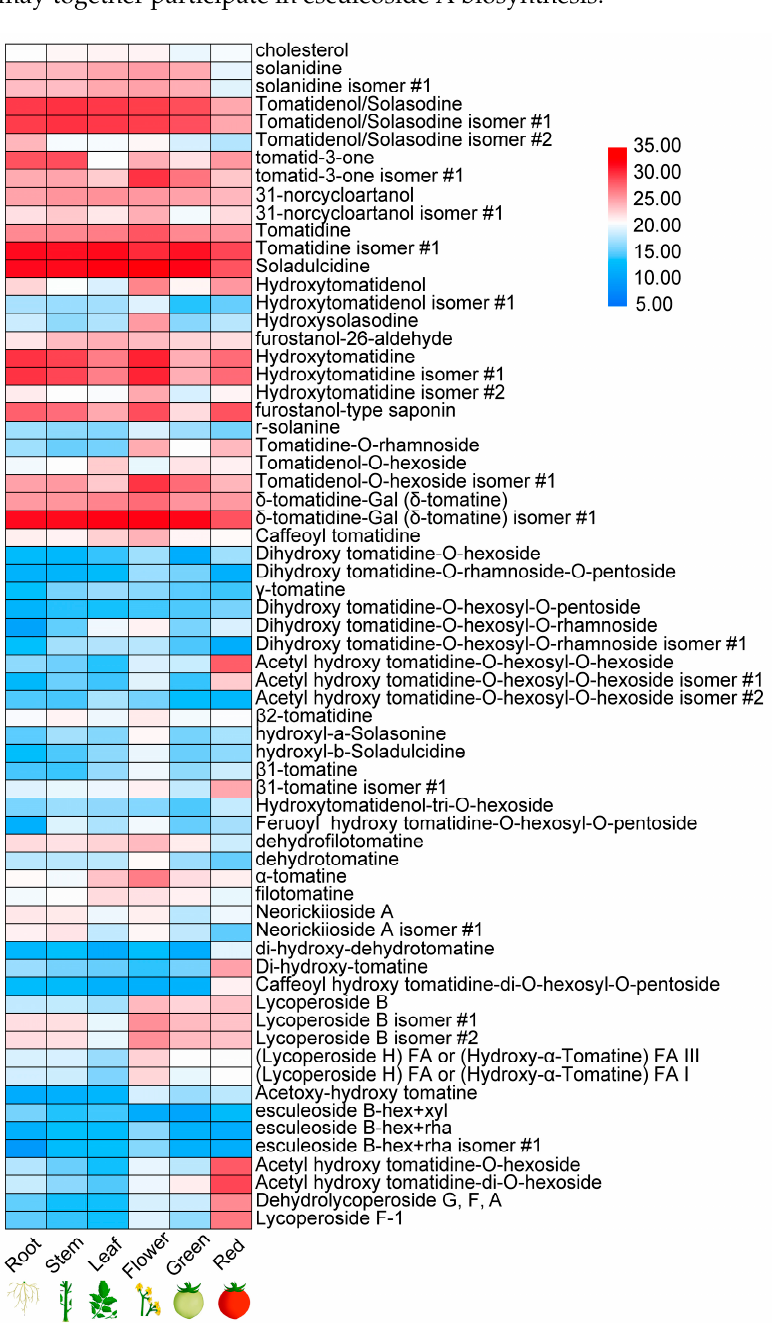
Figure 1. Metabolite contents during fruit development and ripening: diversity of SAs present in different tissues in tomato plants. isomer # : represents an isomer